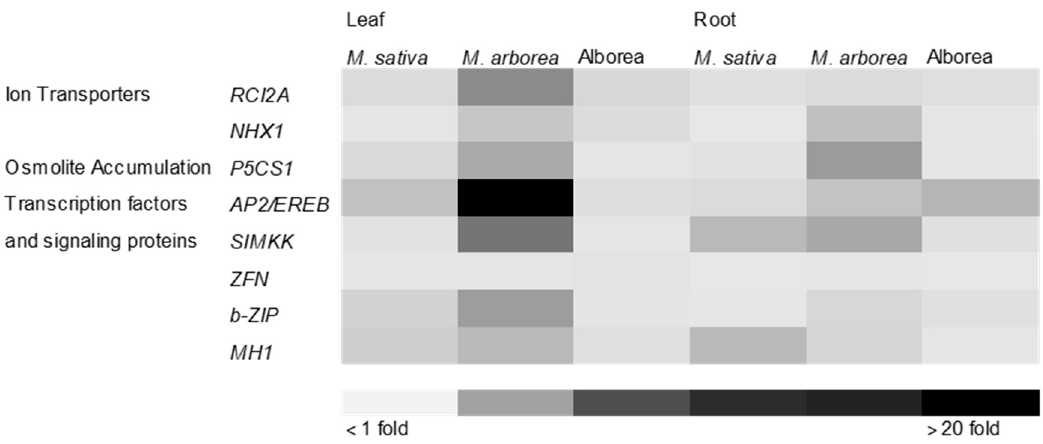
Figure 4. General expression level of RCI2A , NHX1 , AP2/EREB , SIMKK , ZFN , bZIP , MH1 and P5CS1 under drought treatments for M. arborea , M. sativa and Alborea. Expression levels are black and gray-coded to depict the fold change as follows: black (high expression level >20-fold) to gray (low <1-fold).